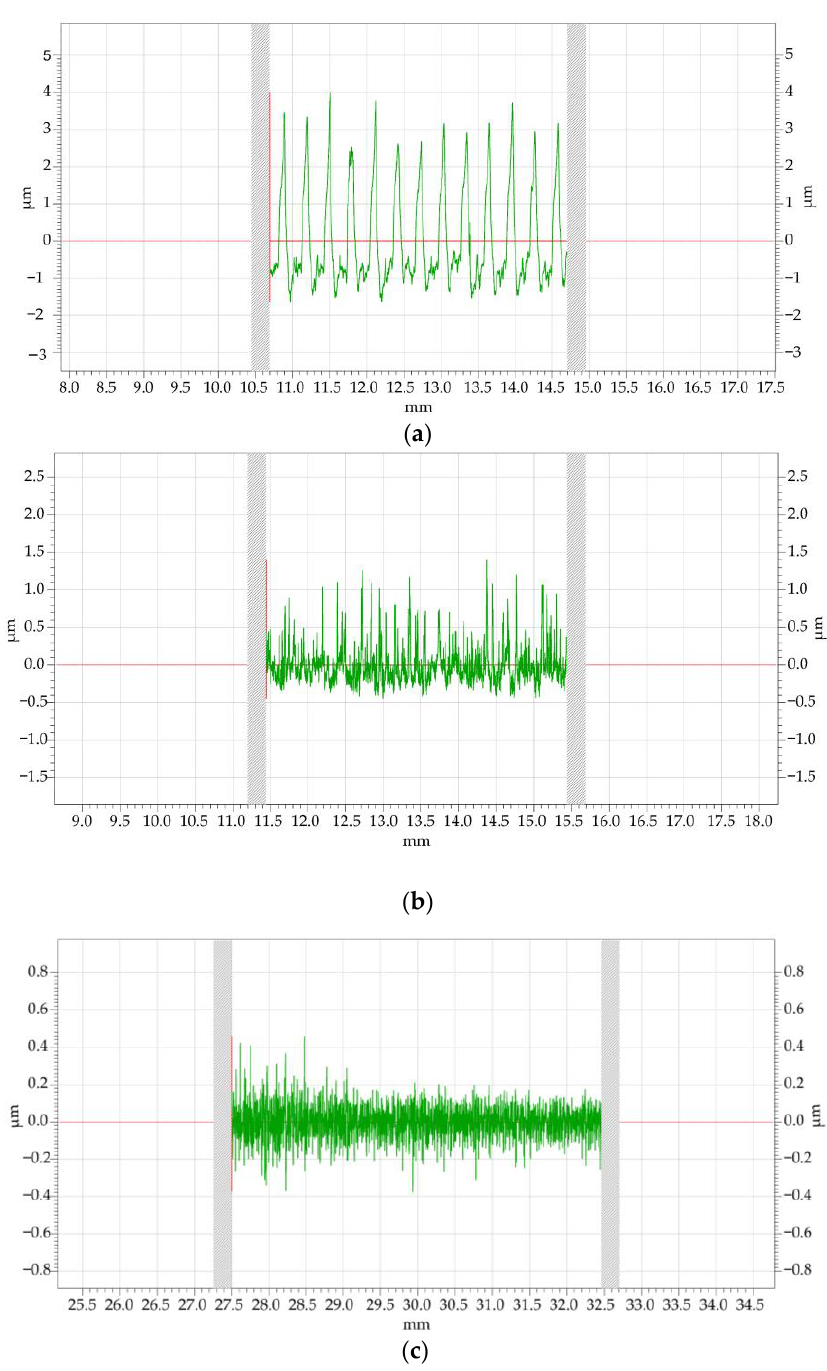
Figure 12. Surface micrograph: ( a ) after milling, ( b ) after MAF, ( c ) after UAMAF.